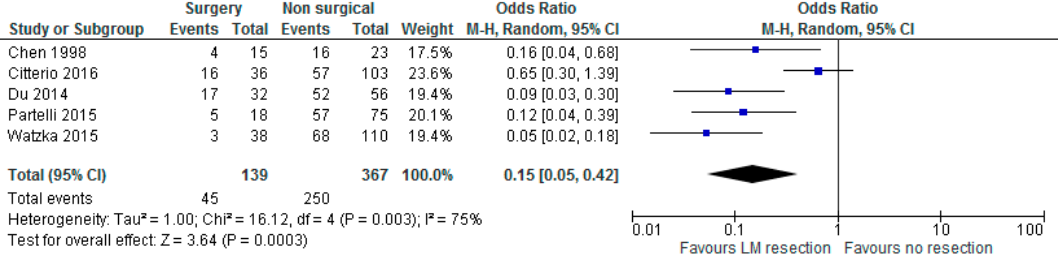
Figure 3. Forest plot for overall survival (OS) after liver metastases (LM) resection versus no resection at all.